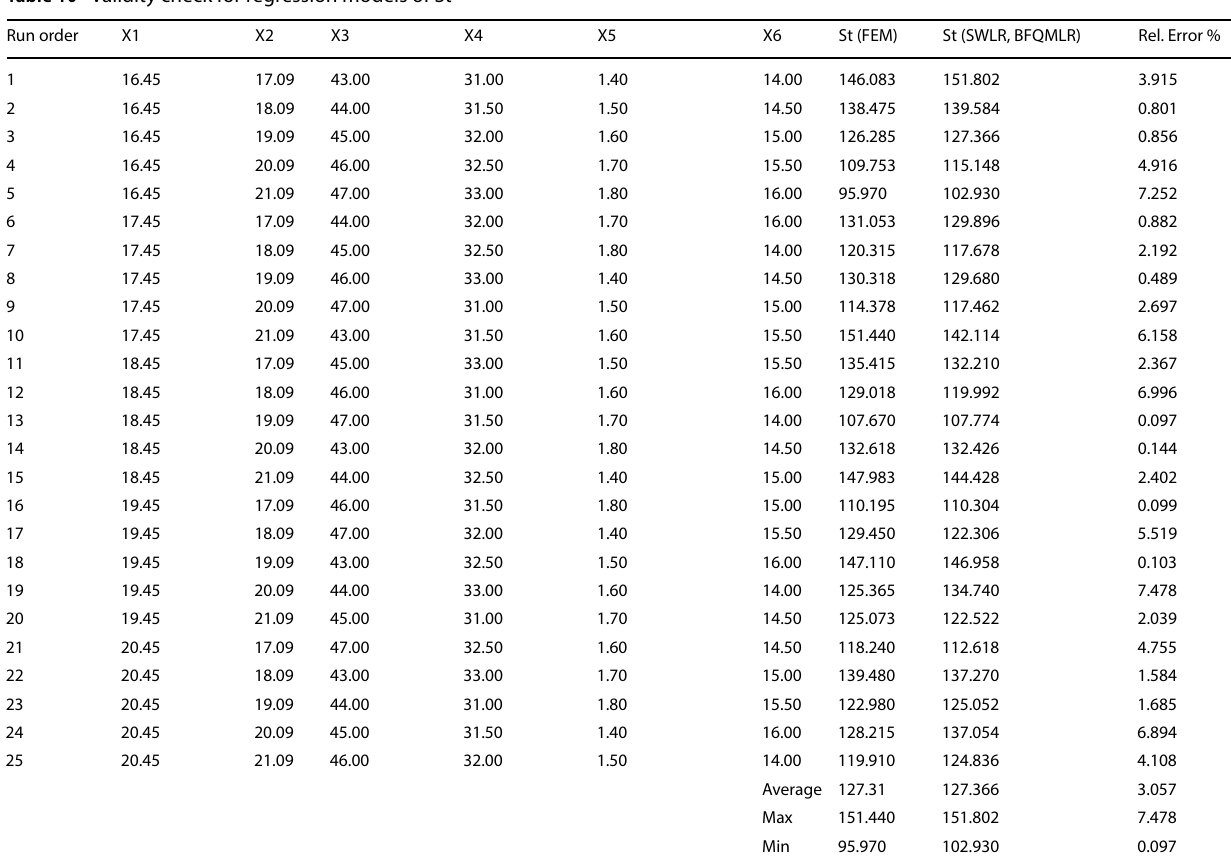
Table 10 Validity check for regression models of St Run order